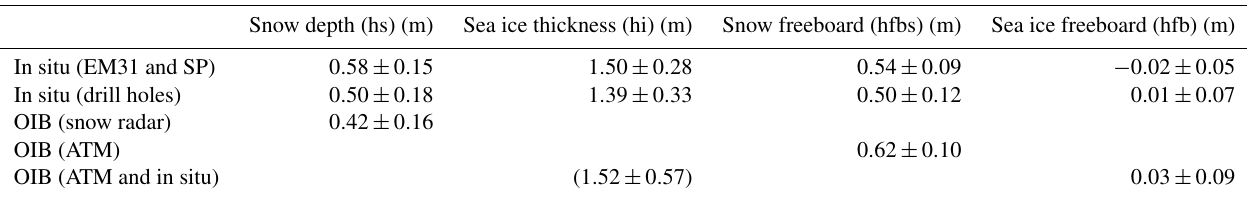
Figure 4. Processed and annotated OIB snow radar echoes surveyed from the 2-D survey field during the third pass on 19 March 2015 at 15:43UTC. The red bounding box indicates the close-up of the region as shown in Figs. 1 and 2. Table 2. Results of snow, sea ice and freeboard measurements and calculations of the 2-D survey field